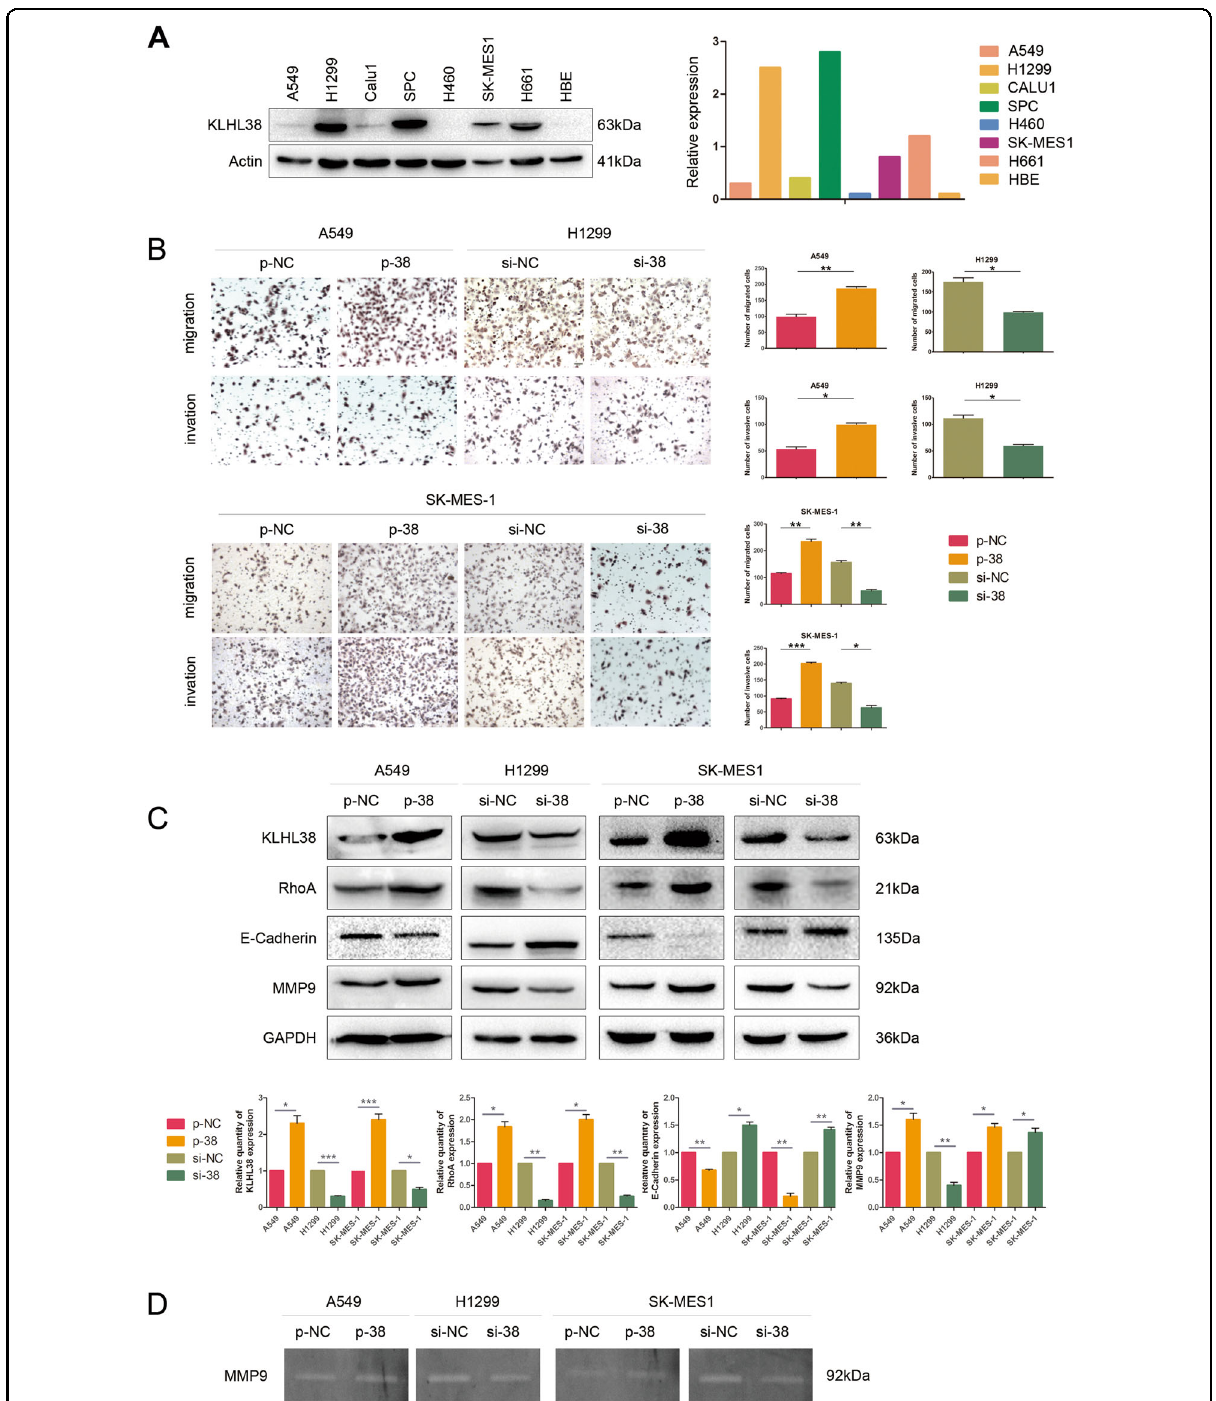
Fig. 2 Effect of KLHL38 expression on the migration and invasion of non-small cell lung cancer (NSCLC) cells. A KLHL38 levels in HBE cells and seven NSCLC cell lines determined by western blotting . B Cell migration evaluated by the transwell migration assay; cells that migrated to the lower chamber were stained with hematoxylin and counted. * P < 0.05; ** P < 0.01. C Expression of KLHL38 and cell migration- and invasion-related proteins in A549, H1299, and SK-MES-1 cells. Relative quanti fi cation of western blot data was based on densitometry analysis. p-NC, cells transfected with pCMV6-myc-DDK; p-38, cells transfected with pCMV6-myc-DDK- KLHL38 ; si-NC, cells transfected with scrambled control siRNA; si-38, cells transfected with KLHL38 -speci fi c siRNA. D Gelatin zymograph assay showing the relationship between KLHL38 and secreted active MMP9.All experiments were repeated three times, error bars as